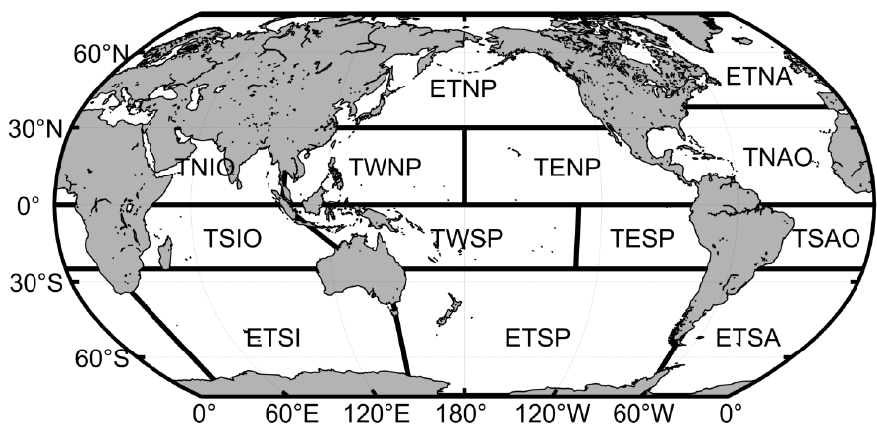
Figure 1. Selected subregions of the oceans: Extratropical South Indian (ETSI), Extratropical South Pacific (ETSP), Extratropical South Atlantic (ETSA), Tropical South Indian Ocean (TSIO), Tropical Western South Pacific (TWSP), Tropical Eastern South Pacific (TESP), Tropical South Atlantic Ocean (TSAO), Tropical North Indian Ocean (TNIO), Tropical Western North Pacific (TWNP), Tropical Eastern North Pacific (TENP), Tropical North Atlantic Ocean (TNAO), Extratropical North Pacific (ETNP), Extratropical North Atlantic